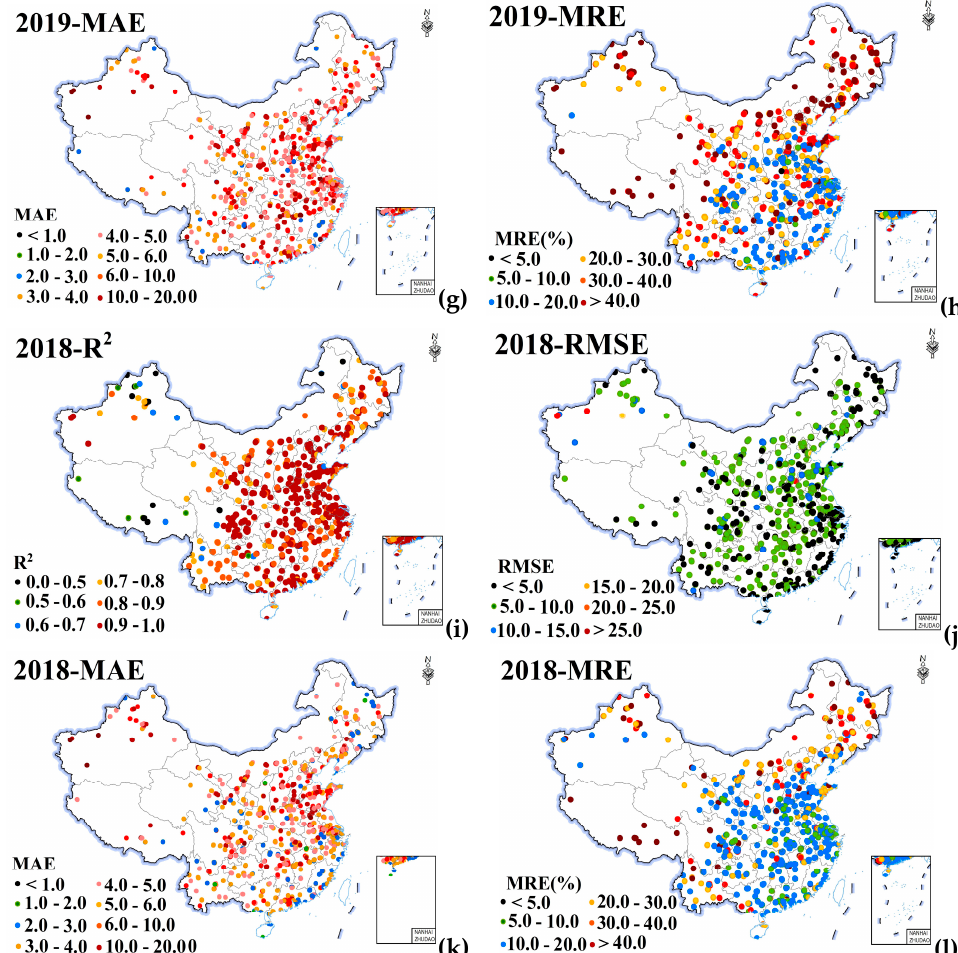
Figure 6. Spatial distribution of R 2 , root means square error (RMSE), mean relative error (MRE), and mean absolute error (MRE). ( a – d ), ( e – h ), and ( i – l ) represent in 2020, 2019, and 2018. There are 1475, 1478, and 1489 sites.